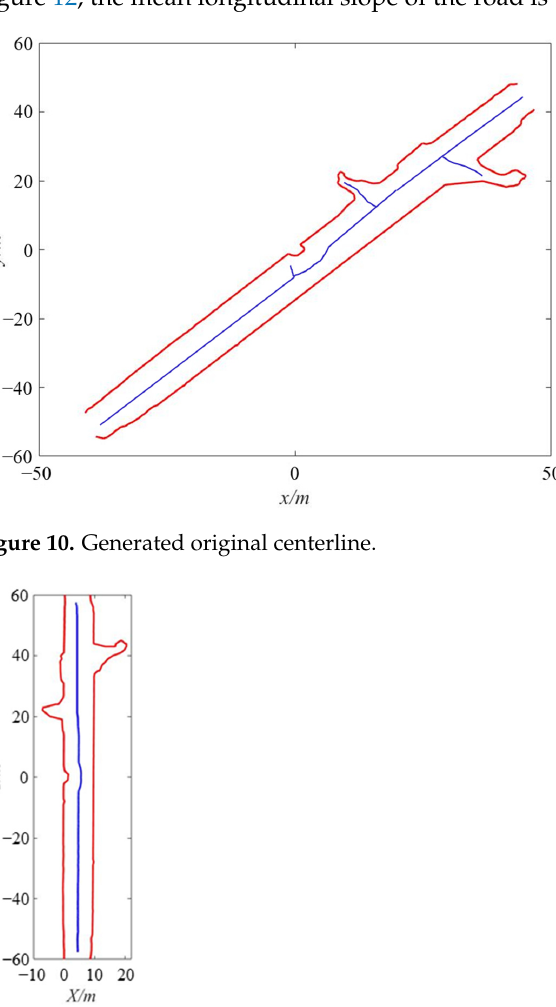
Figure 9. Generated DEM.